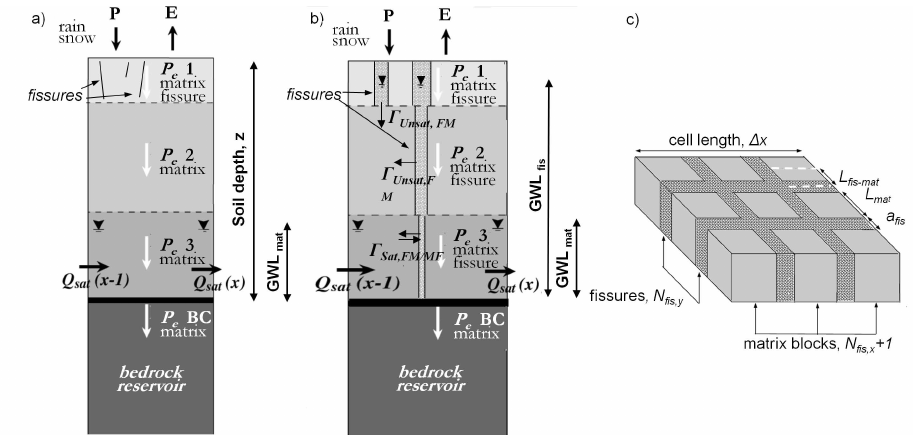
Fig. 2. Schematisation of (a) the original hydrological model (Van Beek, 2002, after Van Beek, 2002; Malet et al., 2005), (b) the hydrological model implemented with this research and (c) fissure representation in the single layer of the soil